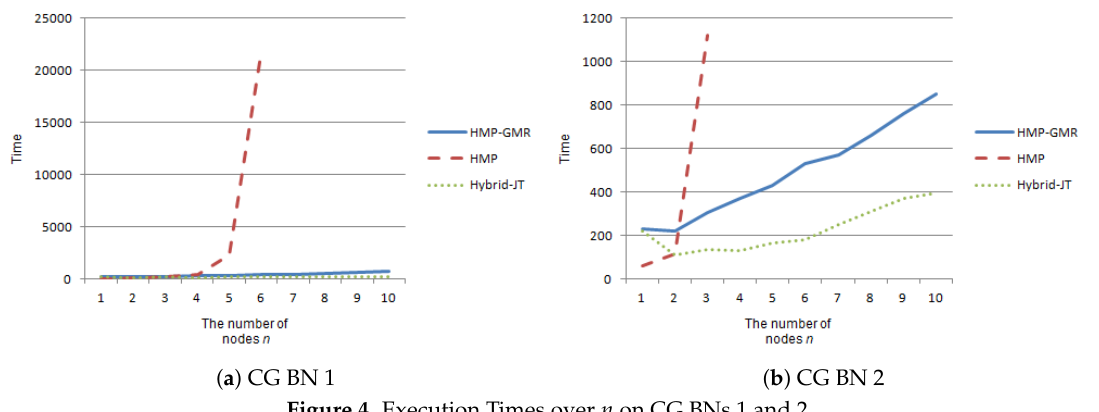
Figure 4. Execution Times over n on CG BNs 1 and 2.